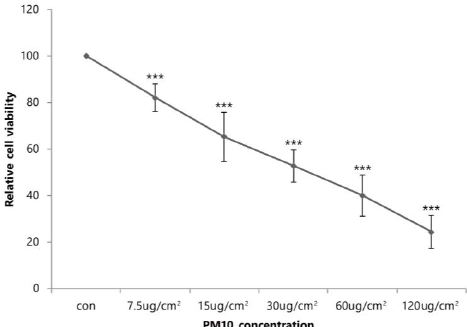
Figure 1. The survival rate of human dermal fibroblasts (HDFs) grown in various concentrations of PM 10 . Data are provided as mean ± SD of three independent experiments. p -values were calculated with respect to control by Student’s t -test. p < 0.001 (***) versus control.